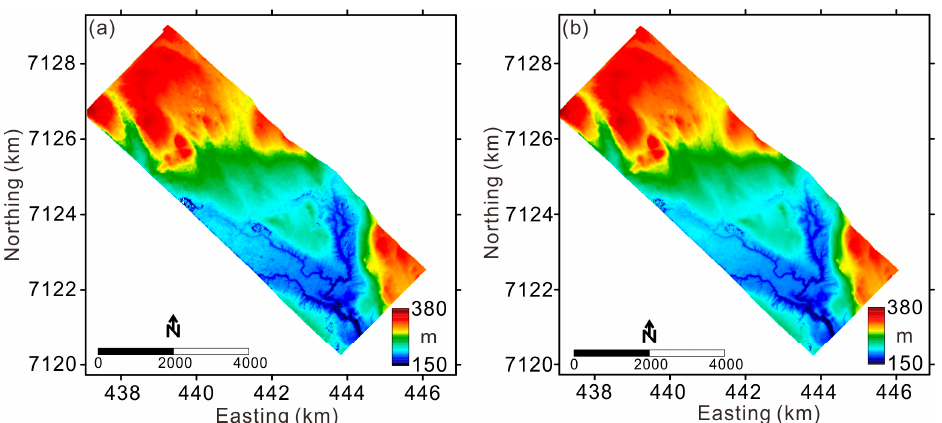
Figure 6. FUDEMs derived by: three-stage ( a ); and WCLSA ( b ).